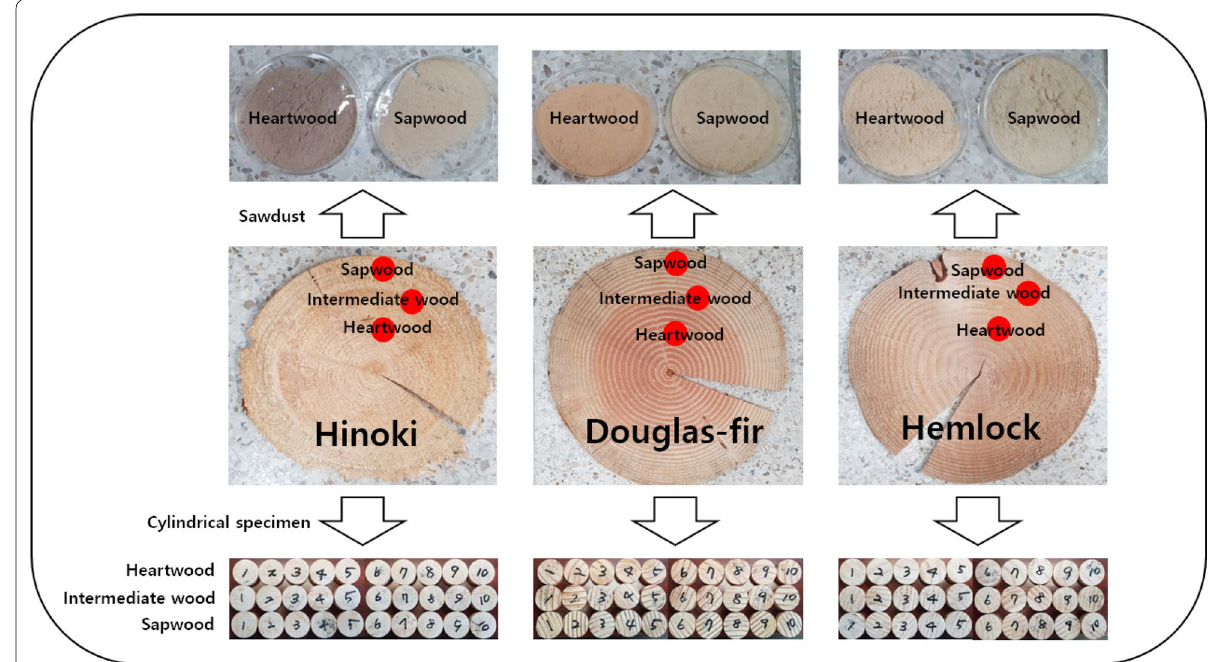
Fig. 1 Preparation of three species of softwood specimens (left: hinoki, middle: Douglas fir, right: